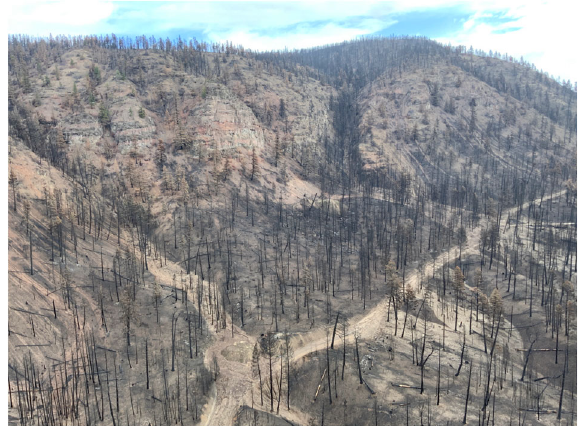
Fig. 10 | Example of post-wild fi re debris fl ows following the heatwave. Post- wild fi re debris fl ows in Nicoamen River watershed triggered by a rainstorm on 16 August 2021. Severely burnt vegetation is shown by blackened trees. Debris fl ows originated as slope wash and rilling on steep burnt